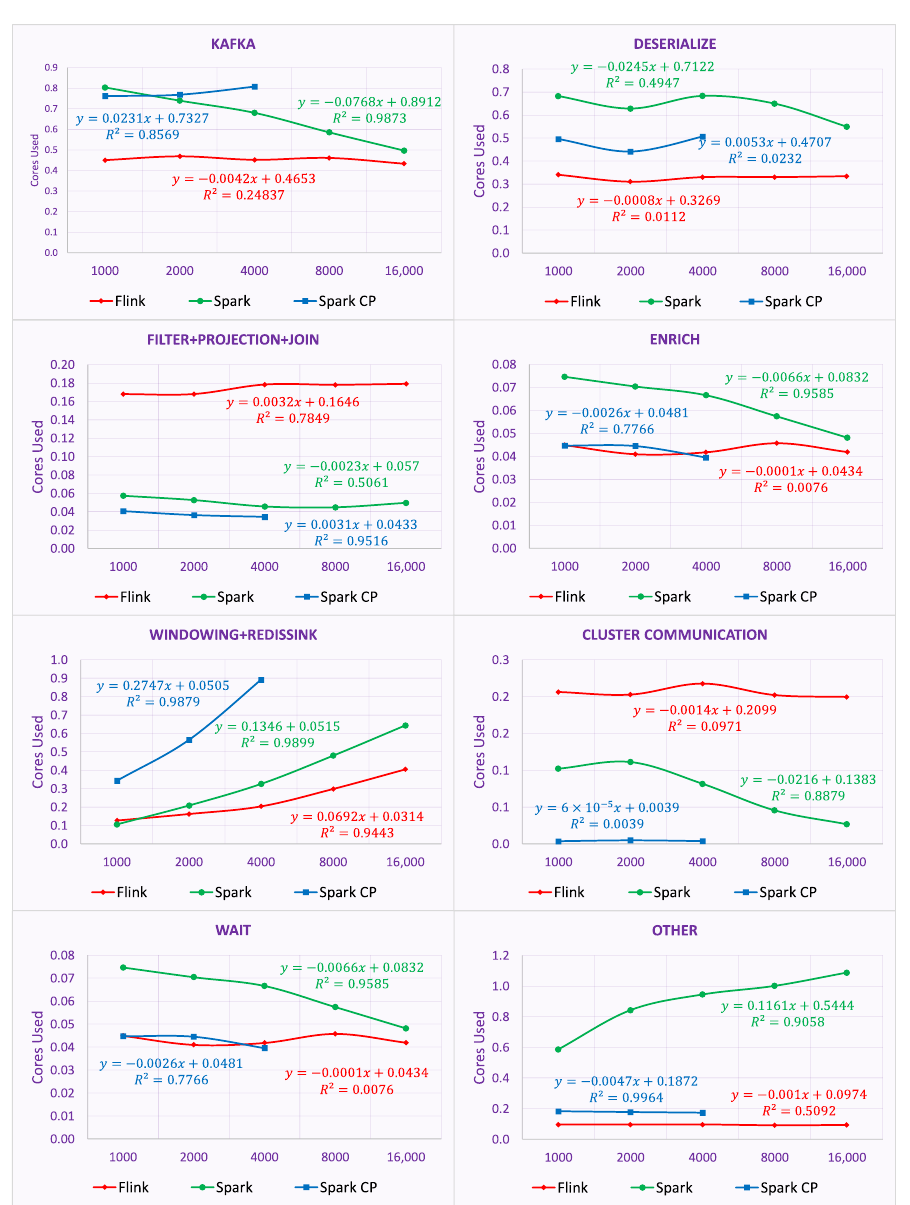
Figure 14. CPU consumption per task when scaling campaigns